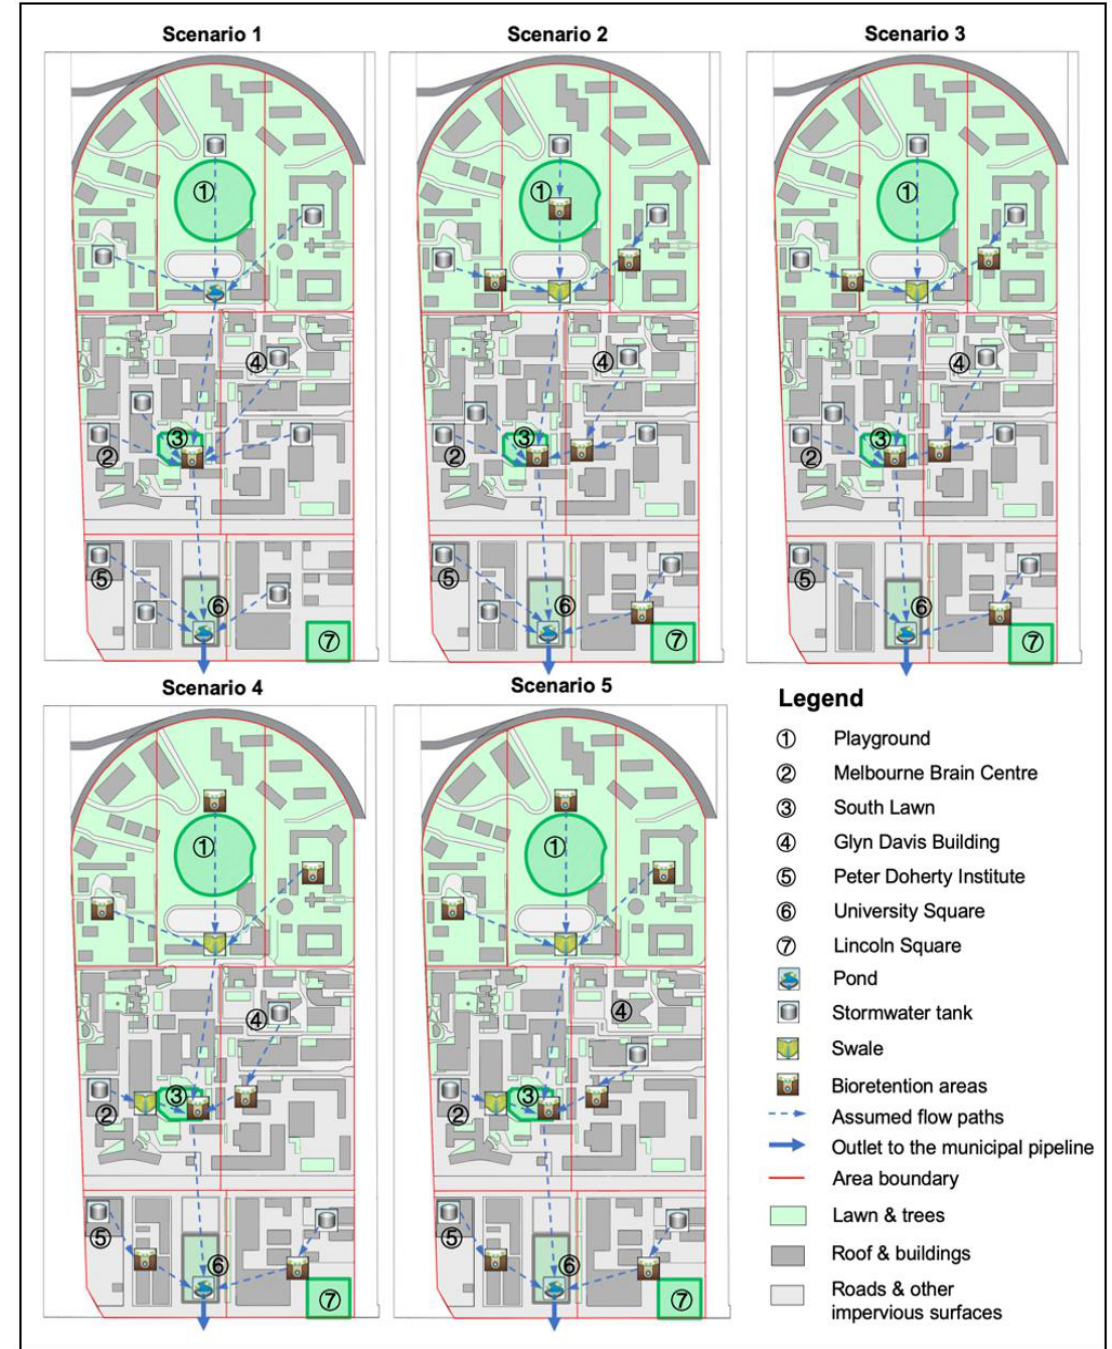
Figure 3. Five designed scenarios.